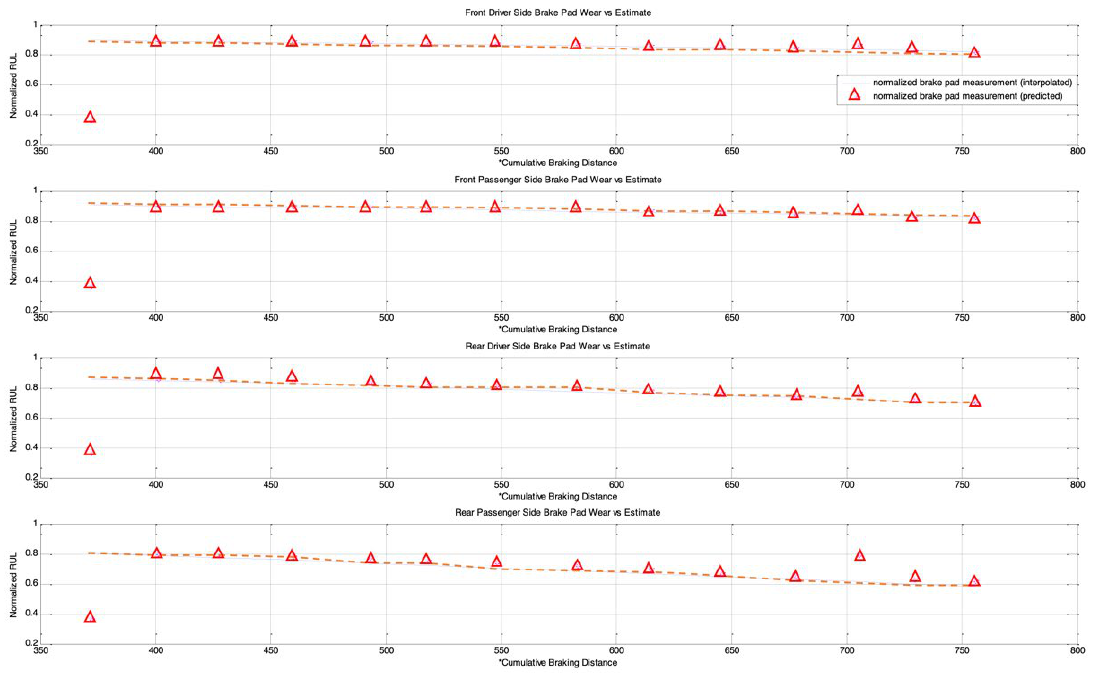
Figure 21. Driver #3, inferred normalized brake wear (dashed-line) vs. predicted brake wear (triangle). Top–bottom shows front driver side, front passenger side, rear driver side, and rear passenger side.